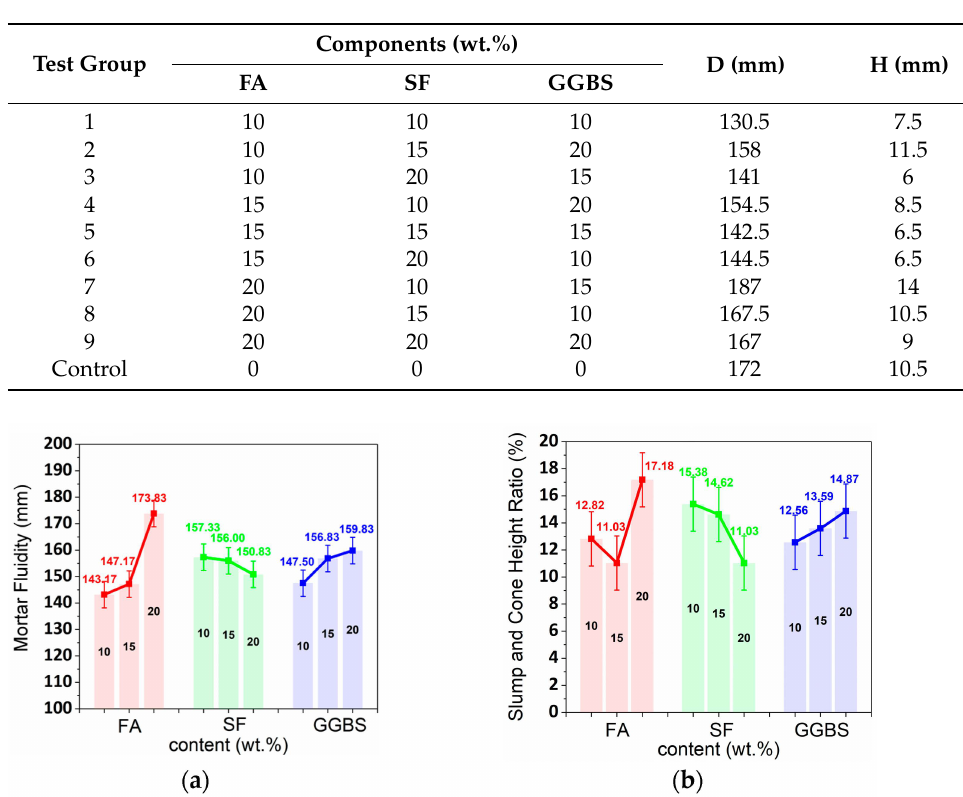
Table 4. Orthogonal experimental table of various test group designs, flow expansion, and slump test data.